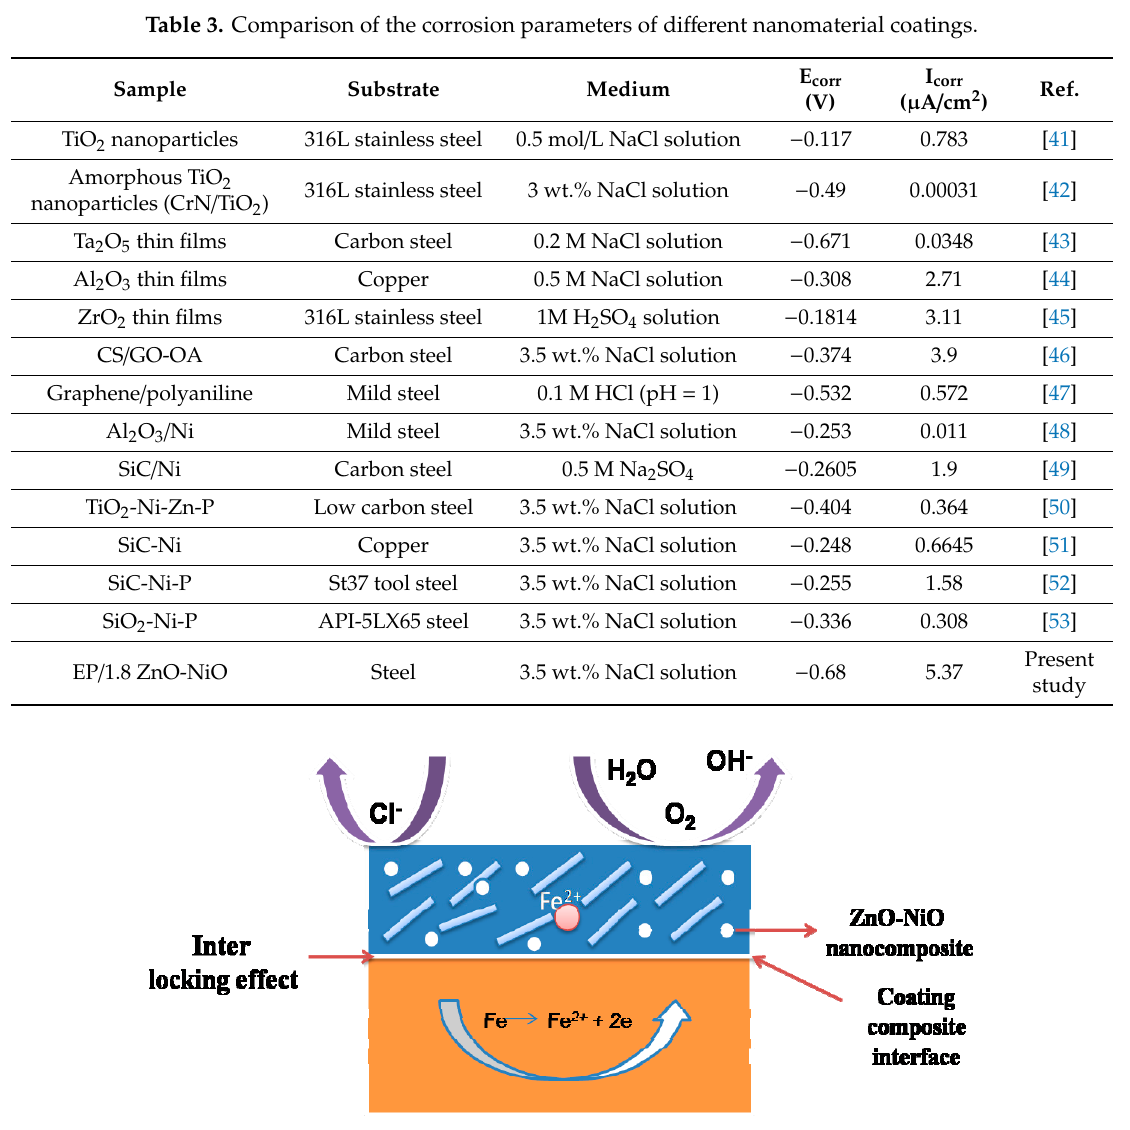
Figure6. Figure 6. Proposed mechanism of the corrosion protection by the metal oxide (ZnO-NiO) nanocomposite.